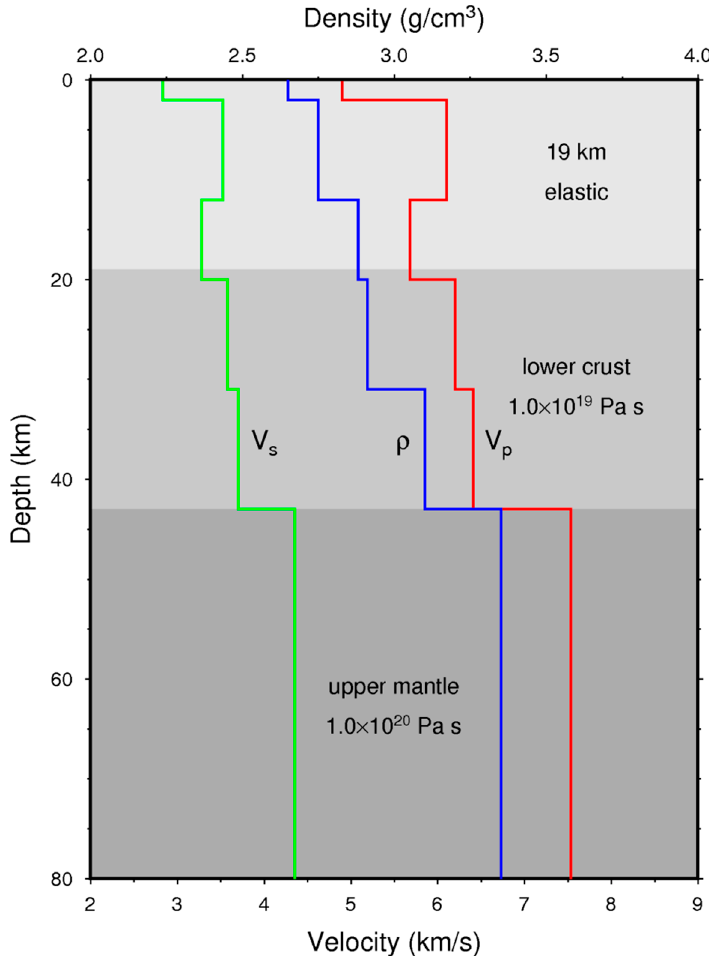
Figure 3. Viscoelastic layered model used in this study. V p is the P wave velocity, V s is the S wave velocity, and ρ is the density. The viscosities of the lower crust and upper mantle are set at 1.0 × 10 19 Pa · s and 1.0 × 10 20 Pa · s, respectively.